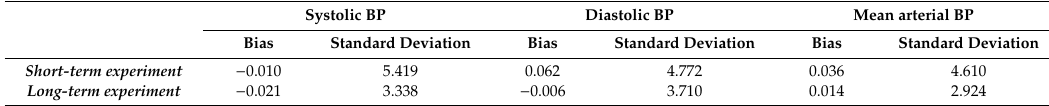
Table 7. Bias and standard deviation (SD) of systolic, diastolic and mean arterial blood pressure. Systolic BP Diastolic BP Mean arterial BP Bias Standard Deviation Bias Standard Deviation Bias Standard Deviation Short-term experiment − 0.010